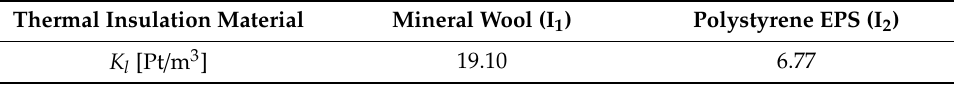
Table 3. Results of LCA analysis of thermal insulation materials.